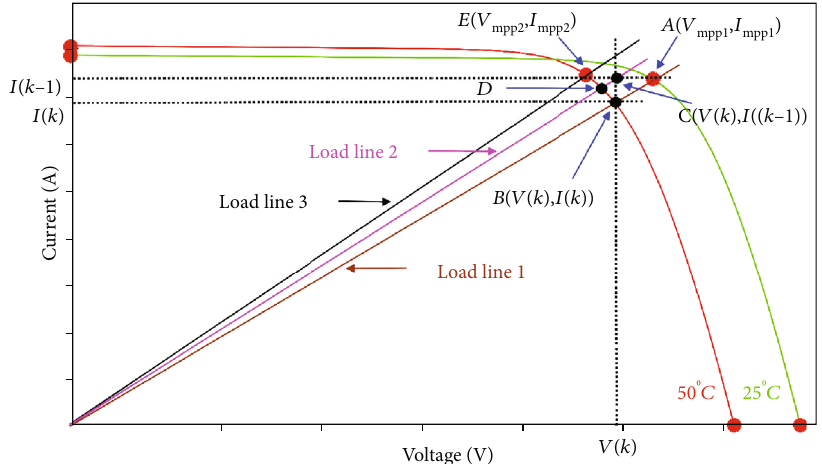
Figure 10: Operating point (OP) movement for the improved method under sudden increase of temperature.